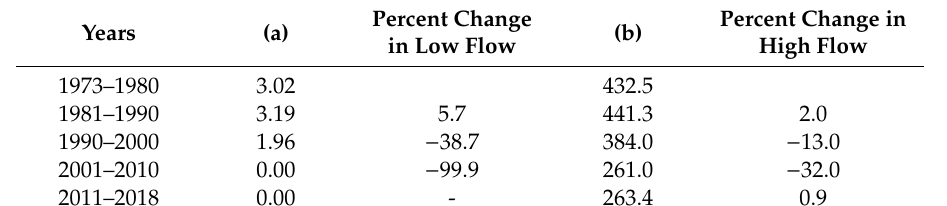
10 of 20 Table 2. Minimum and Maximum Flow (m 3 s − 1 ) of Different Duration in Gumara River at the ‘outlet’. These are the common variables in the Ecological Limits of Hydrologic Alteration (ELOHA) analysis. The abbreviations are listed in Table 1. Duration Median (Q50) Coeff. of Disp.; (Q75- Q25)/Q50